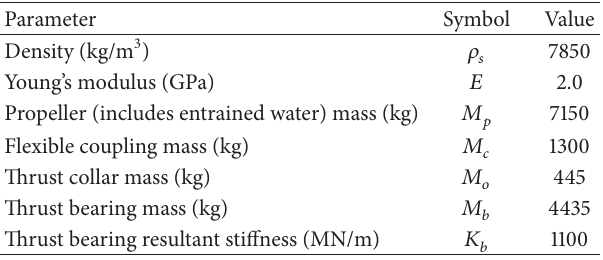
Table 3: Parameters of propulsion shafting